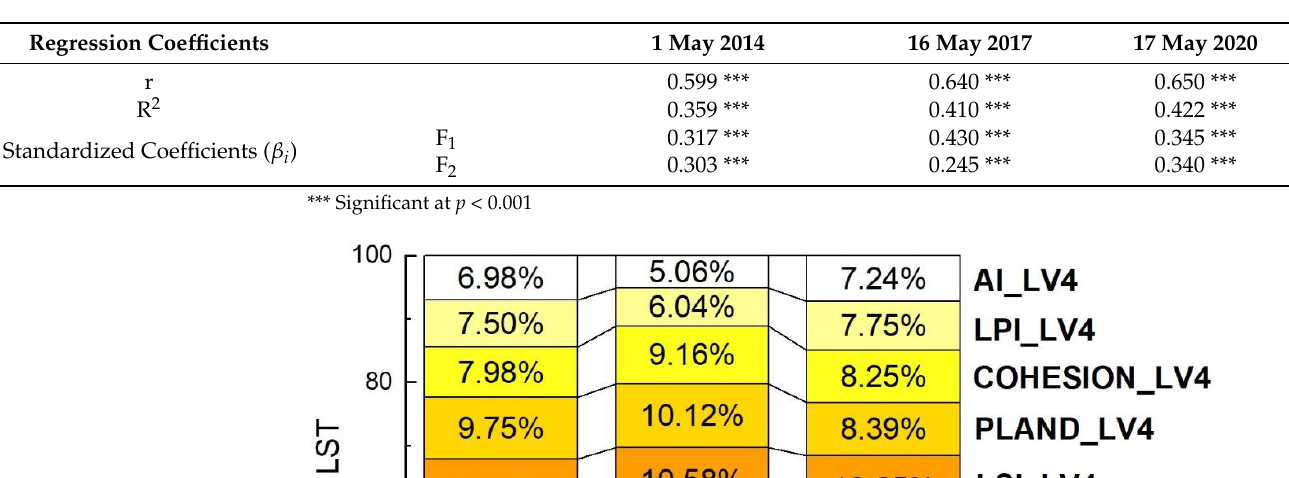
Table 8. Multiple linear regression coefficients between normalized LST and principal variables (F 1 and F 2 ).